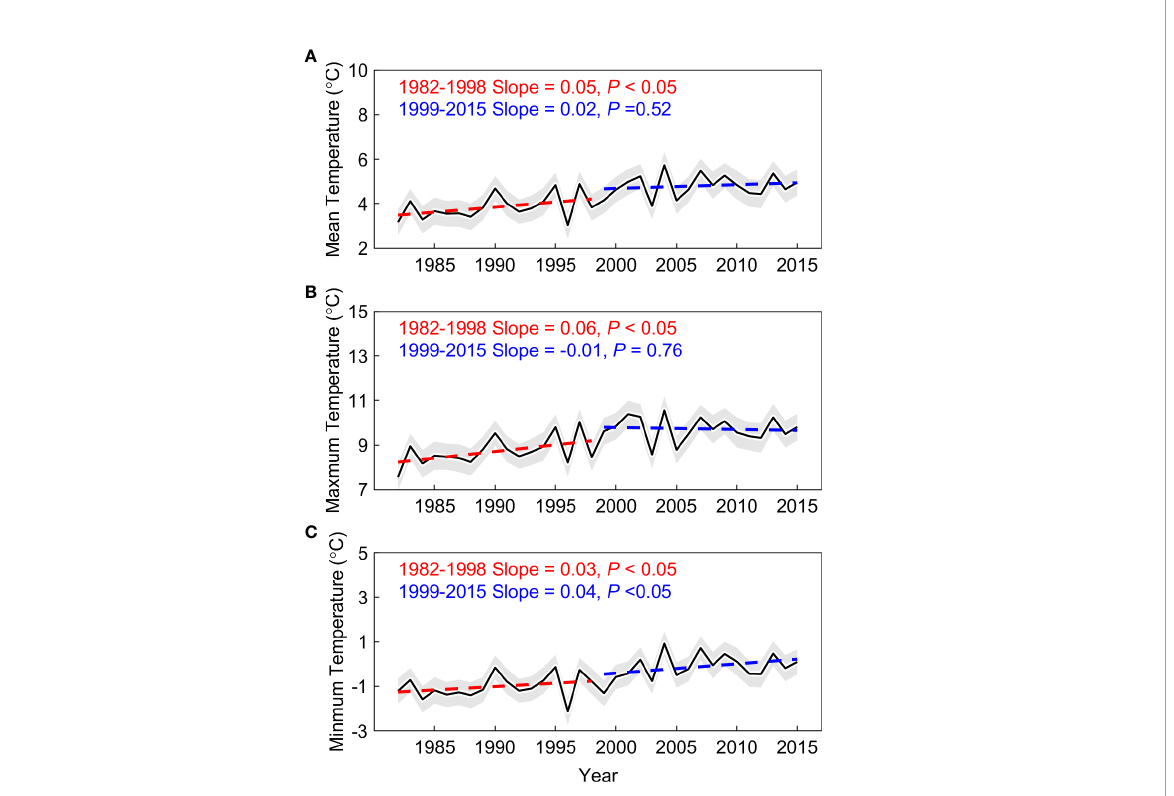
FIGURE 3 Multi satellites-based vegetation spring phenology in the Pan-Third Pole. (A) Spring phenology from GIMMS Normalized difference vegetation index (NDVI3g), and the period is from 1982 to 2015. (B) Spring phenology from Moderate Resolution Imaging Spectroradiometer (MODIS) C6 (NDVIm), and the time period 2001 to 2015. (C) Spring phenology from Solar ‐ Induced chlorophyll Fluorescence (SIF), and the period is from 2007 to 2015. All spatial distribution patterns represent the mean value of their period